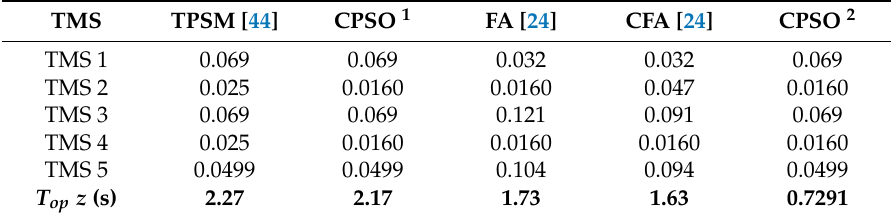
Table 11. Comparison of the optimized TMS with the literature for Case III.